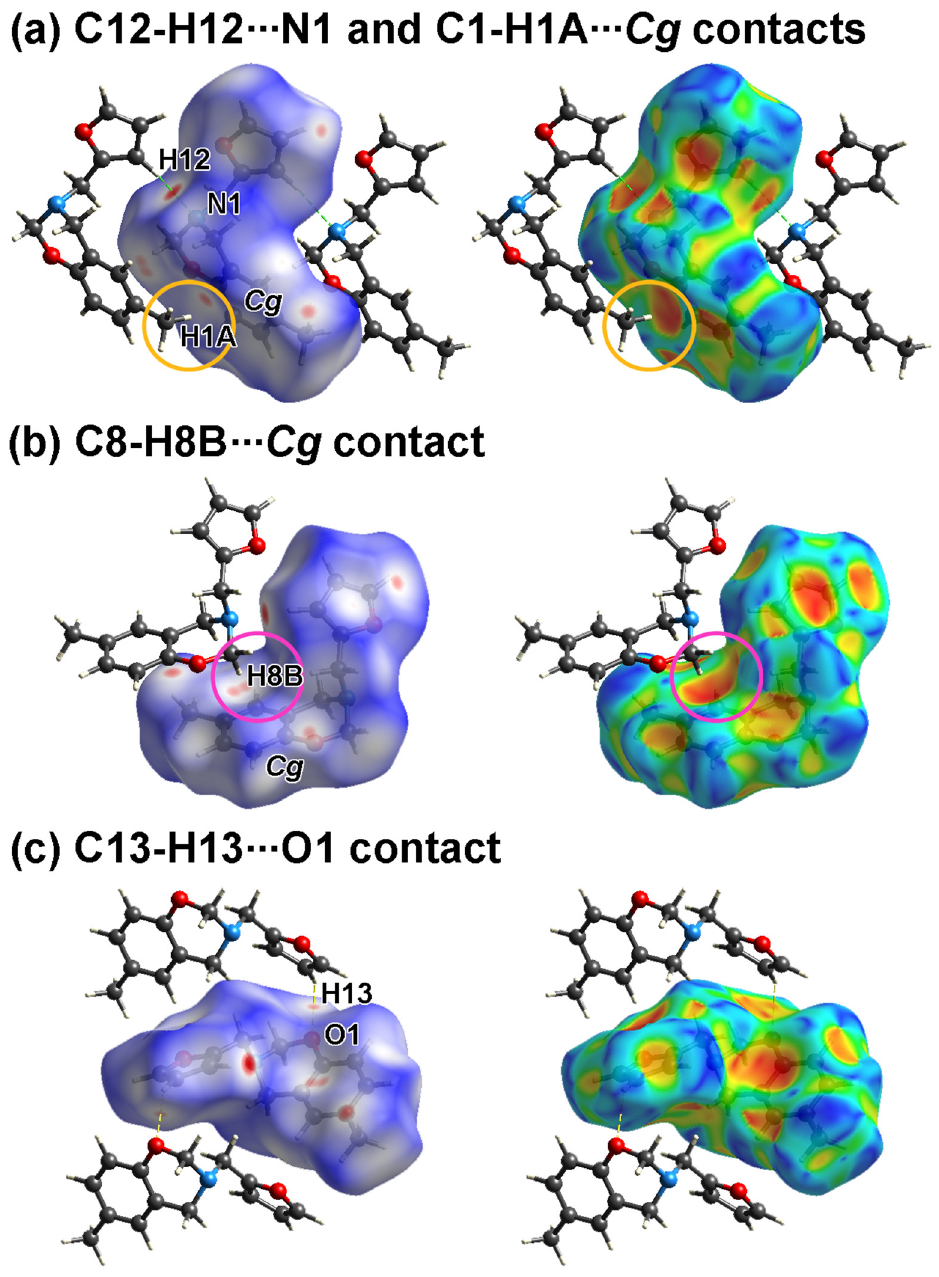
Figure 3. Views of the Hirshfeld surfaces for the benzoxazine (I) mapped over d norm in the range from − 0.155 to +1.157 arbitrary units (left) and the shape-index property (right), each highlighting ( a ) the C12–H12···N1 (green dash line) and the C1–H1A··· C g (orange circle) contacts, ( b ) C8–H8B··· C g contact (magenta circle), and ( c ) the C13–H13···O1 contact (yellow dash line).